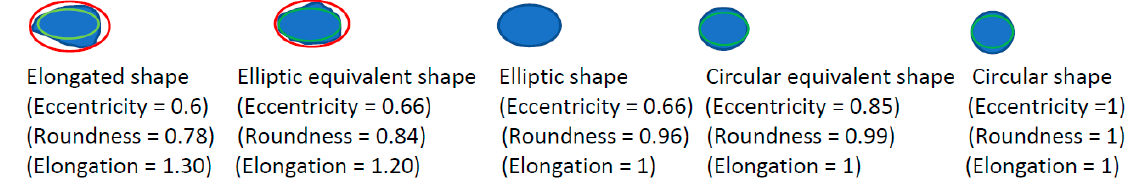
( b ) binary image Figure 13. Another example of results for a cyan print with a cell angle of 60°. % of dots belonging to category ID1 (34%), ID2 (0%), ID3 (0%), ID4 (0%), ID5 (55%), ID6 (11%, most of them are at the border of the figure). There is no missing dot. In total, 62% of dots have an elliptic shape, while 25% of dots have an elongated shape (less than 1% has a circular shape). 3.7. Global Analysis vs. Individual Analysis (Step 7) Considering the heterogeneity of dot patterns and the random distribution of these dot patterns on print samples (as illustrated for example in Figure 13), we hypothesize that, to properly characterize and identify a print, it is necessary to analyze it at the global level—that is to say, to statistically analyze the distribution of the dots printed on these samples. The experimental results reported in Tables 1–3 show some statistical results for 18 print samples. 4. Experimental Results The efficiency of the dot segmentation method was evaluated by visual evaluation, meanwhile the accuracy of some computed values (size of the major and minor axis, area,